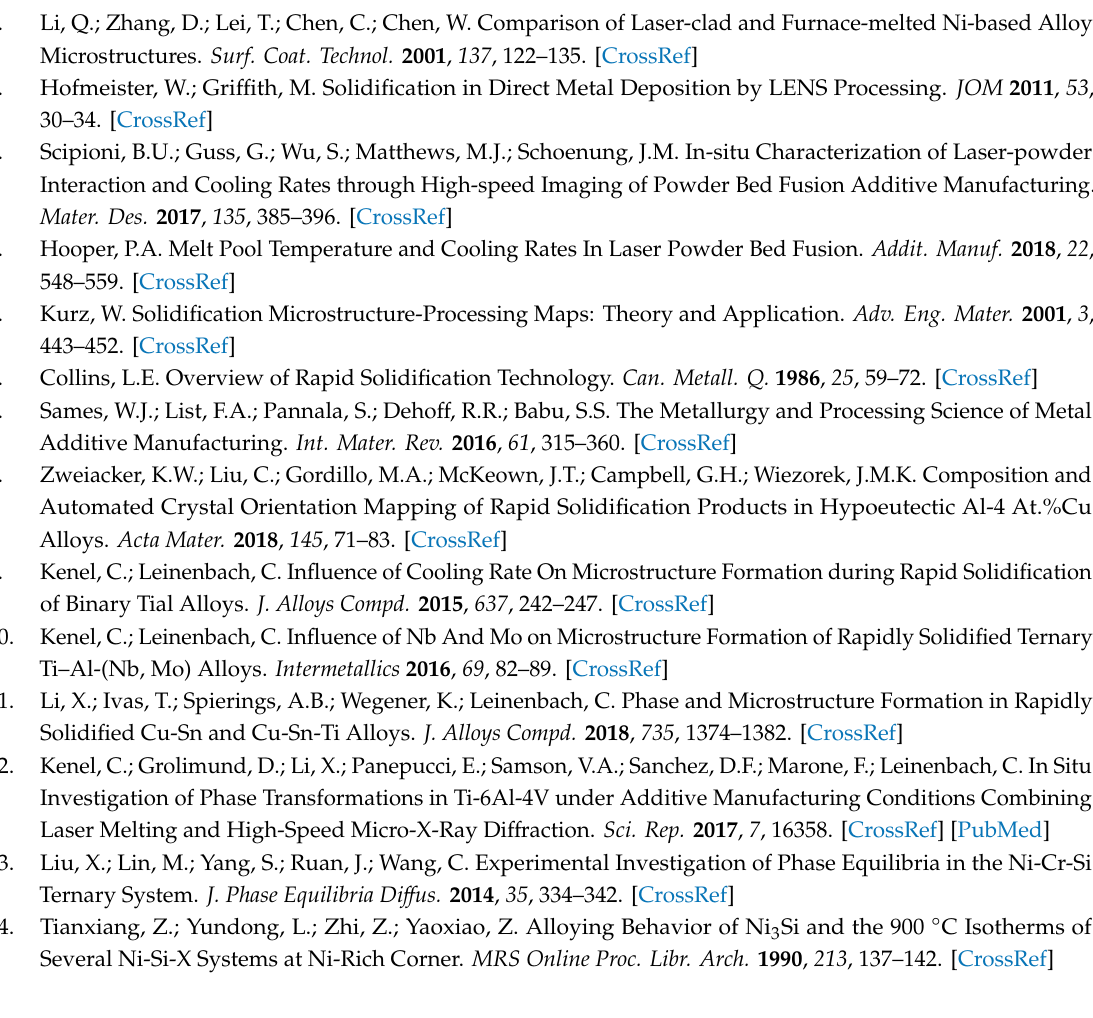
Table S1: List of crystallographic parameters of phases referred to in the present work, Table S2: Table of relevant invariant reactions, Figure S1: 2D pattern of amorphous ring of hot melt at t = 4005 ms (left image) and di ff raction spots of solidified crystals (right image) at t = 4029 ms in the Ni14Cr12Si